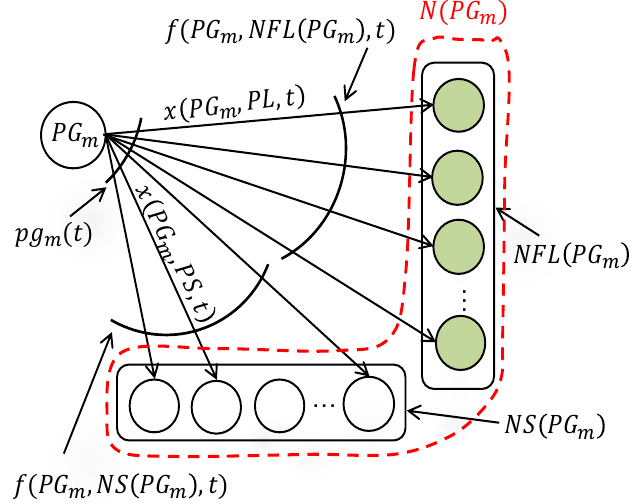
Figure 4. Connections between power generators and neighboring power devices.